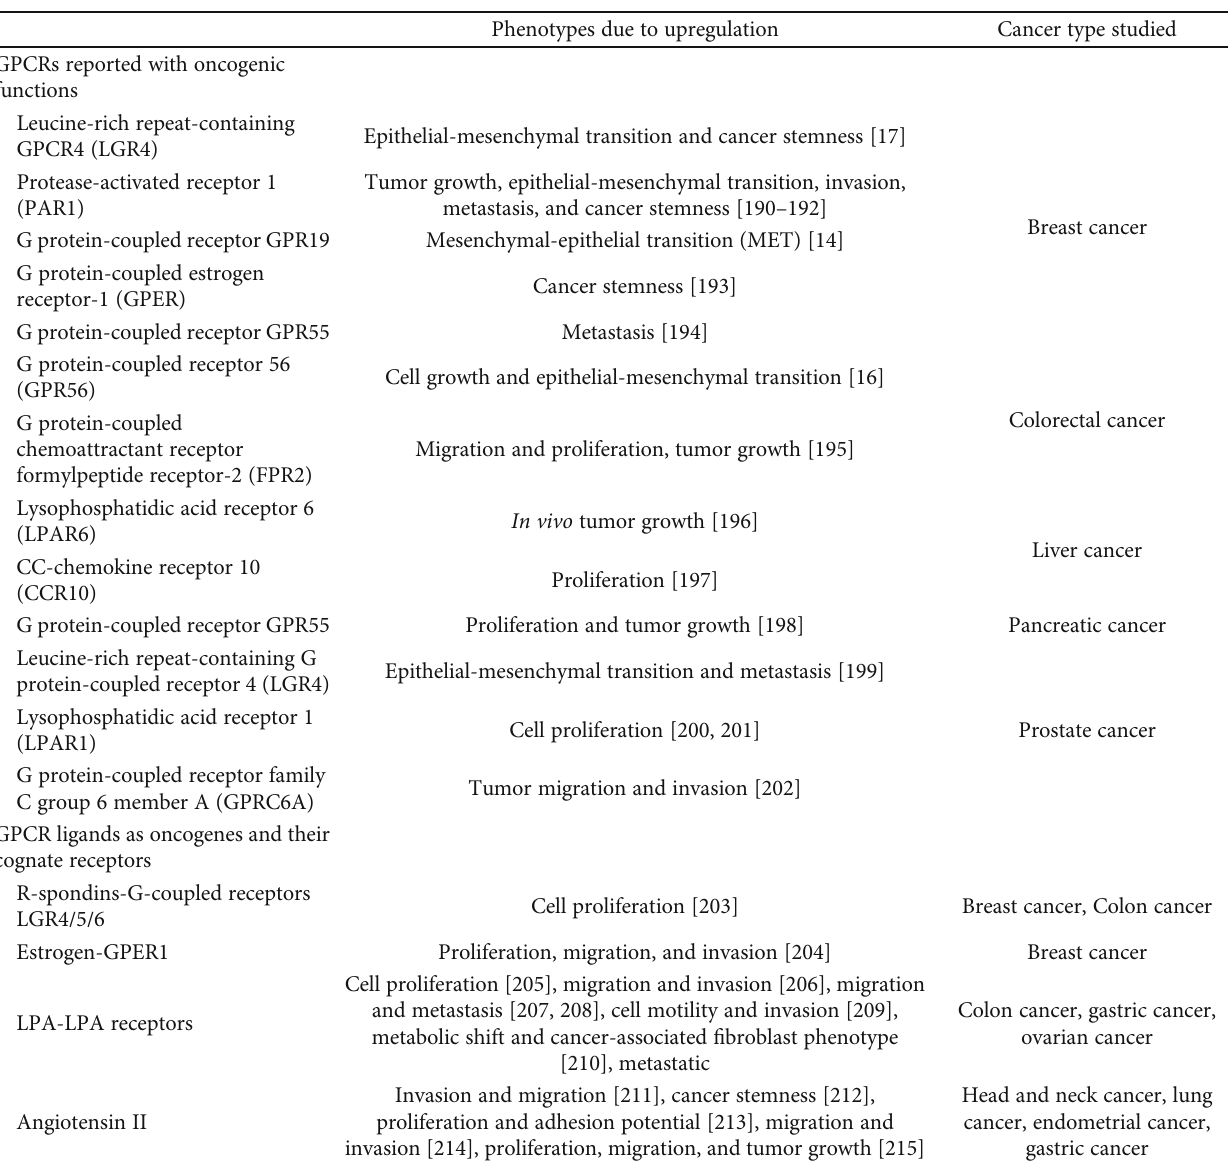
Table 2: Oncogenic GPCRs in